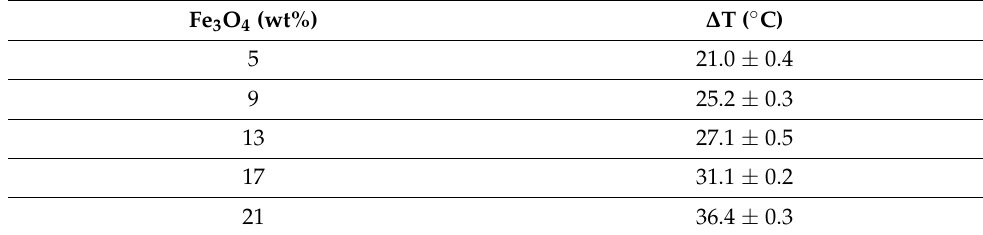
Table 2. Temperature rise depending on the concentration (wt%) of Fe 3 O 4 NPs. Adapted from